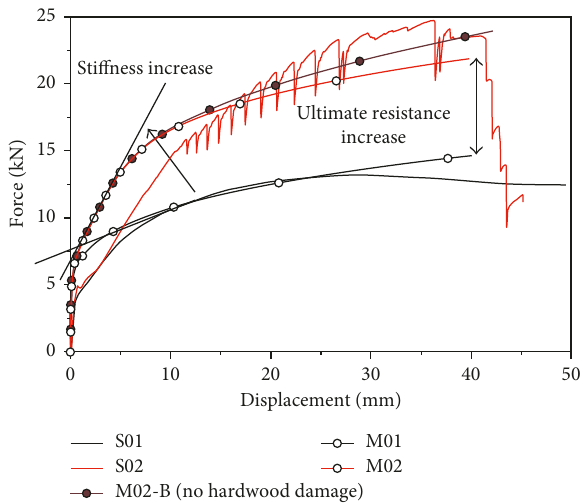
Figure 5: Load-displacement response of the examined specimens, as obtained from the reference experiments [12–14] and via nu- merical simulations